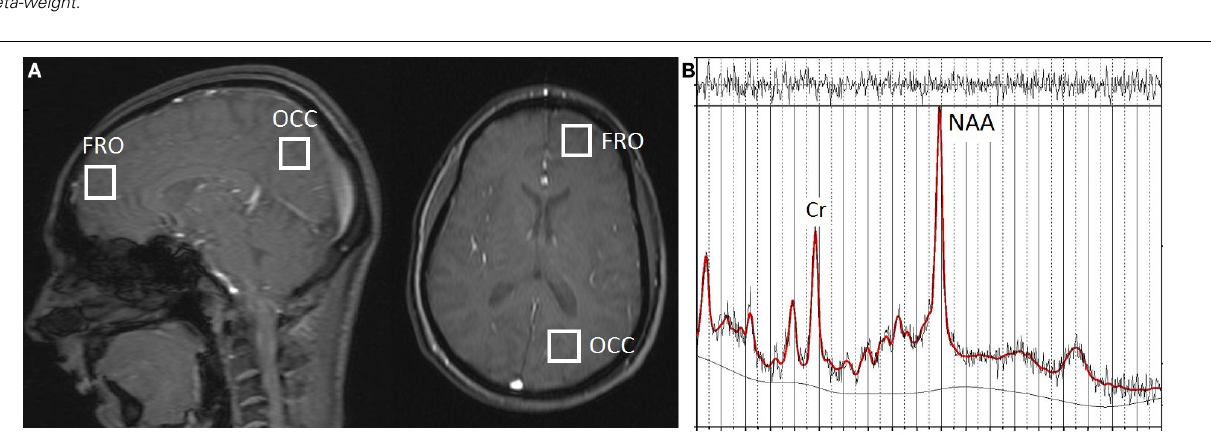
FIGURE 1 | (A) Approximate localization of 1 H-MRS voxels in frontal (FRO) and occipitoparietal (OP) cortex shown in the sagittal and axial planes with a 5-plane localizer ( TR = 20ms, TE = 5ms, 10